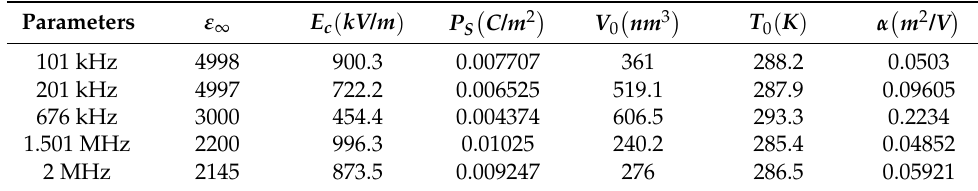
Table 1. The calculated parameters by fitting Equation